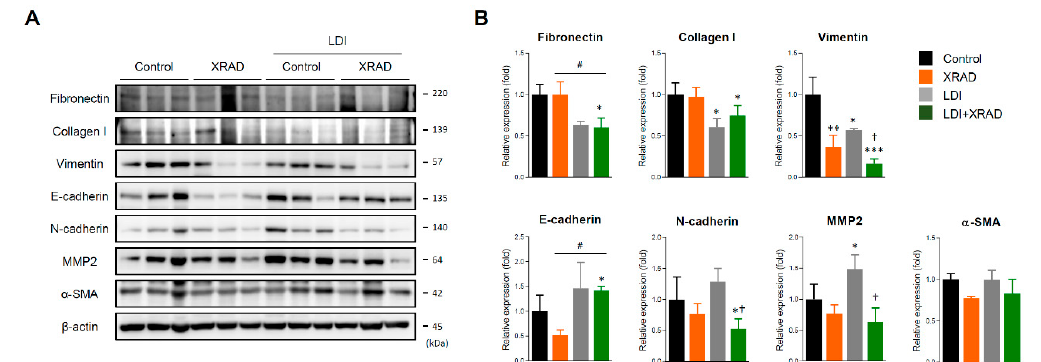
Figure 4. LDI synergistically inhibits EMT proteins combined with high-dose RT. ( A ) The expression of EMT proteins such as fibronectin, collagen I, vimentin, E-cadherin, N-cadherin, MMP2, and α -SMA in primary tumor were detected by Western blot. ( B ) The relative expression of proteins was quantified by densitometry using Image J software and normalized by the levels of β -actin. Data represent means ± SEM of three independent experiments. * p < 0.05, ** p < 0.01, *** p < 0.001 vs. control, † p < 0.05 vs. LDI, # p < 0.05 vs. XRAD. Detailed information about western blot can be found at Figure S2.